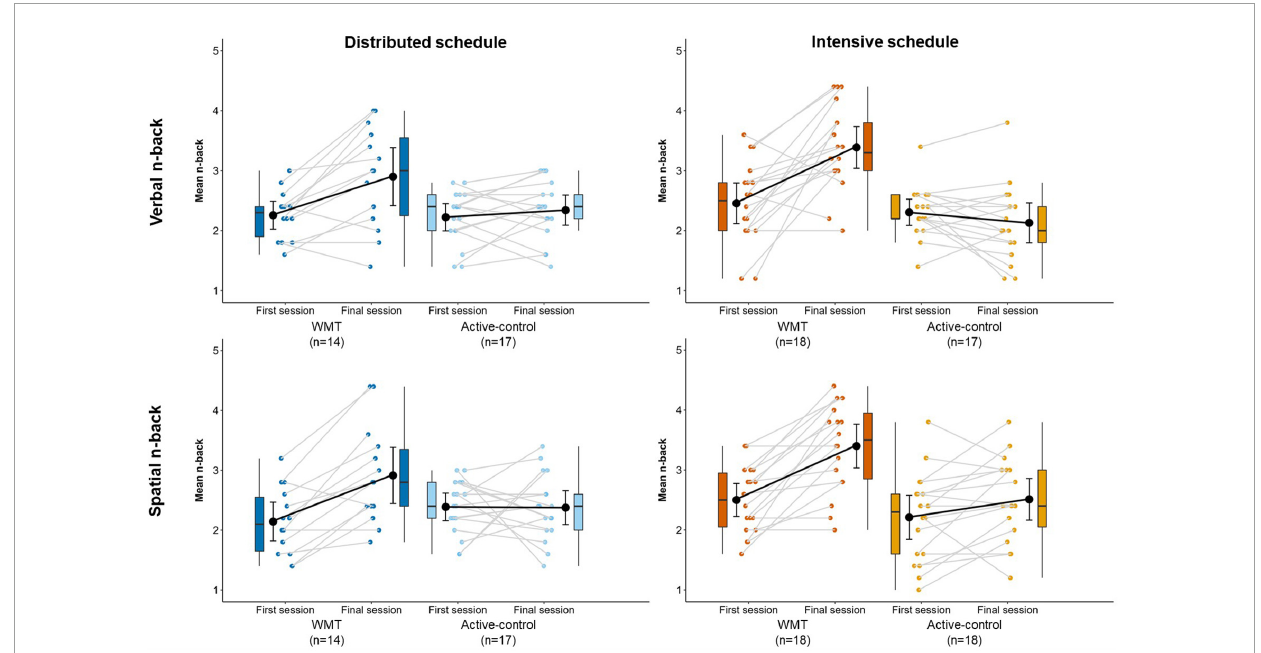
FIGURE4 Performance on the verbal (top) and spatial (bottom) n-back training tasks at the first and final training sessions, separately for distributed groups (left) and intensive groups (right) . Box plots represent the median (crossbars), 1st and 3rd quartile (upper and lower hinges, respectively), and the range of the data (whiskers). Single data points represent individual participants. Black circles and error bars show the group mean and 95% confidence interval.